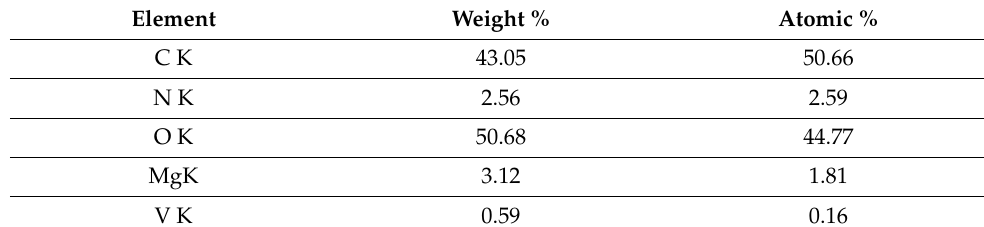
Table 1. EDX qualitative and quantitative data of Mg 3 (VO 4 ) 2 /MgO/GO@CA.